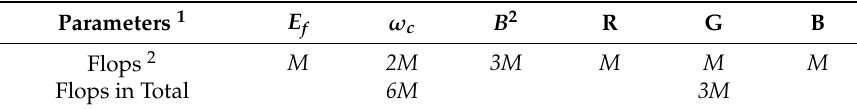
Figure 6. Comparison of waveforms between parameters S and the (RMS bandwidth) 2 of the UHF-B Table 1. Floating point operations of different frequency spectrum.